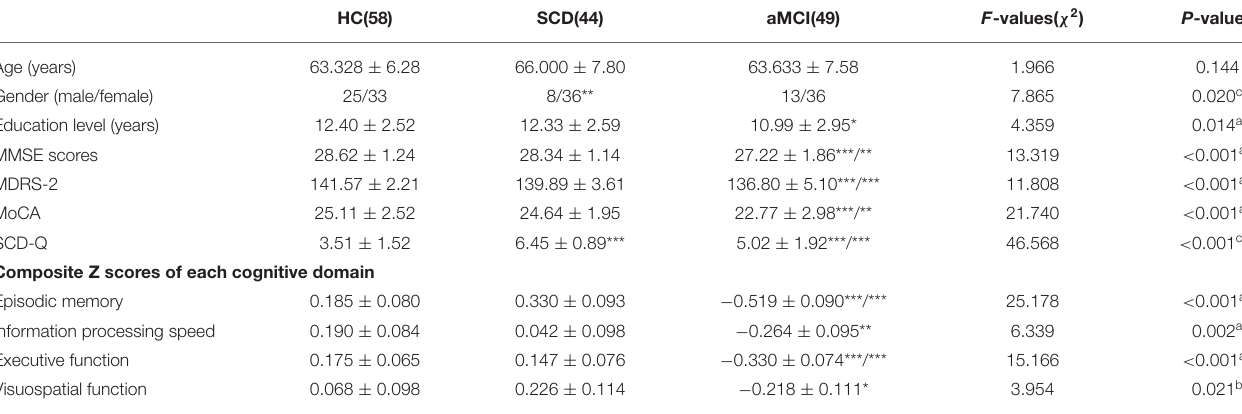
TABLE 1 | Demographics and clinical measures of three groups, including SCD, aMCI, and